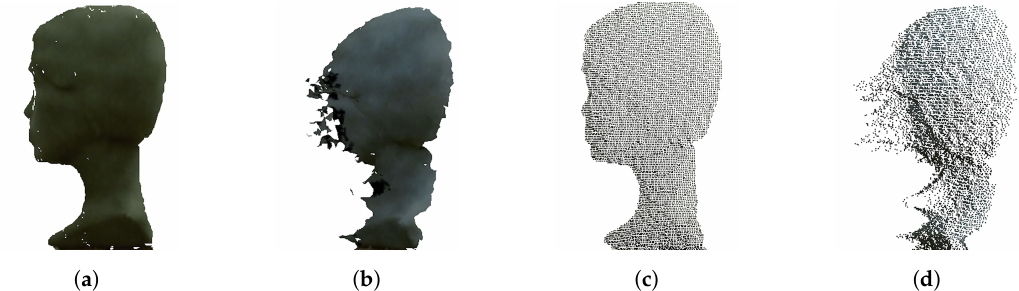
Figure 4. Reconstructed 3D model of static object: ( a ) 3D mesh reconstructed from depth image without interference. ( b ) 3D mesh reconstructed from depth image with interference. ( c ) Point cloud data from depth image without interference. ( d ) Point cloud data from depth image with